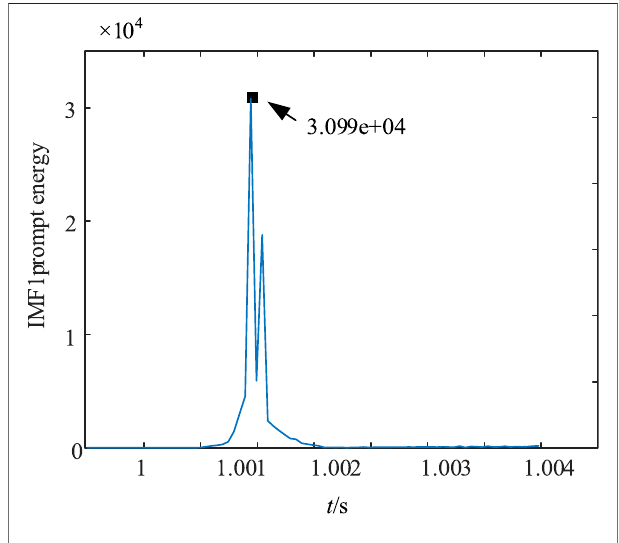
FIGURE 12 | IMF1 component energy